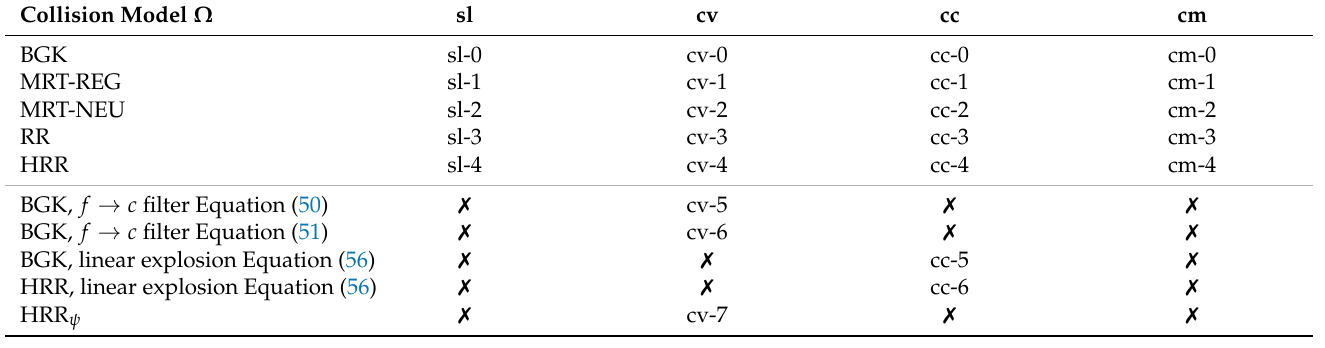
Table 2. Overview of variants examined in the numerical study, sl : Single level, cv : Cell-vertex, cc : Cell-centered, cm : Combined, all cv and cc cases above the light grey midline are computed without f → c restriction and with uniform explosion, respectively.